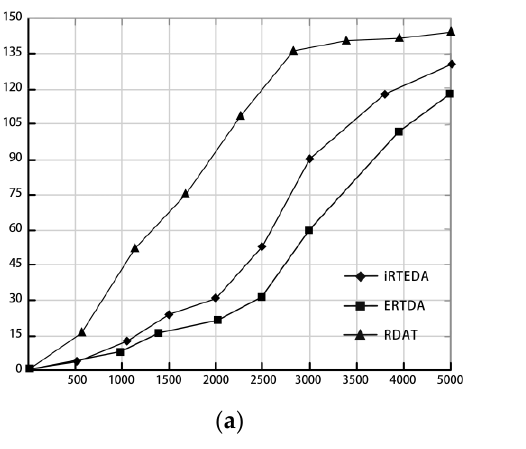
Figure 3. The consumption comparison of three algorithms. ( a ) The comparison of node death rates of three algorithm models. ( b ) The comparison of energy consumption rates of three algo- rithm models.